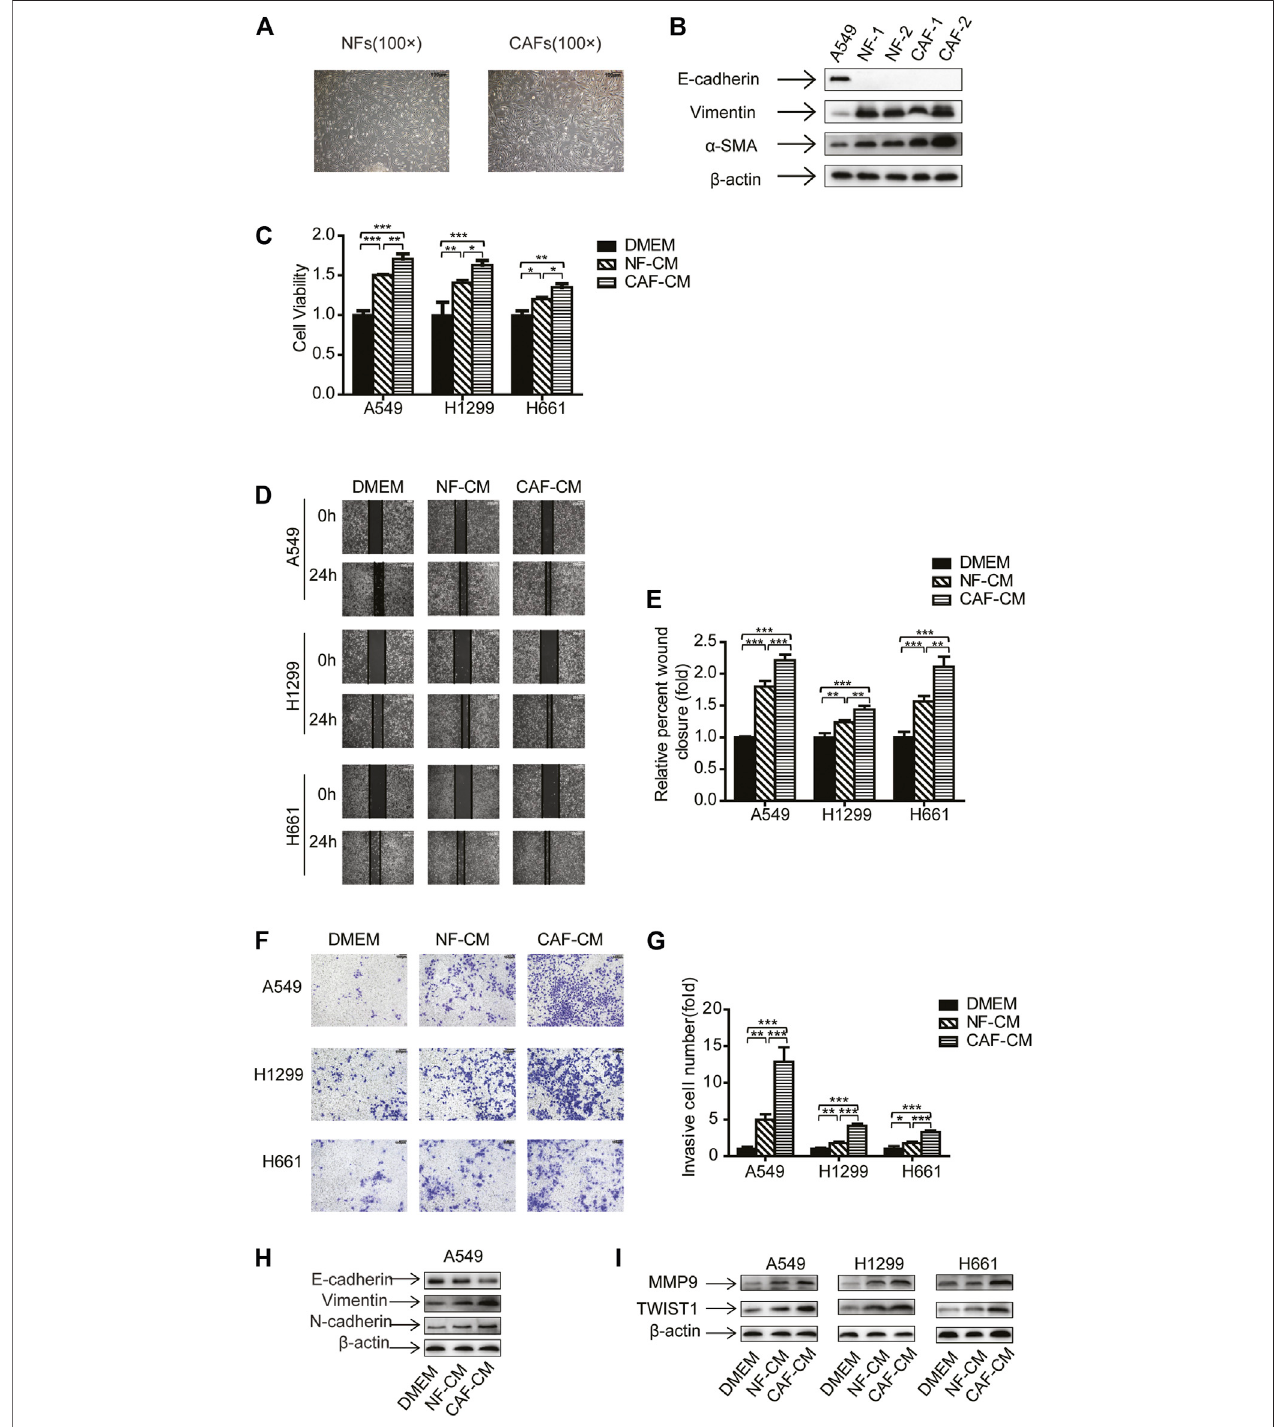
FIGURE 1 | CAFs enhanced migration and invasion of NSCLC cells. (A) The morphology of cultured primary NFs and CAFs. Scale bar, 100 μ M (B) The gene expression was detected by Western blots. (C) Lung cancer cells were cultured in NF-CM or CAF-CM. Cell growth was examined by CCK-8 kit after 48 h. (D,E) Cell invasion was detected by wound healing assay after 24 h. Scale bar, 200 μ M (F,G) Cell migration was examined by transwell assay after 48 h. Scale bar, 100 μ M (H,I) Thegeneexpressions weredetected byWestern blotsafter48 h. Valuesrepresent themean ± SDfrom3independent experiments. Therewerethreereplicates in each independent experiment. * p < 0.05; ** p < 0.01; *** p < 0.001.